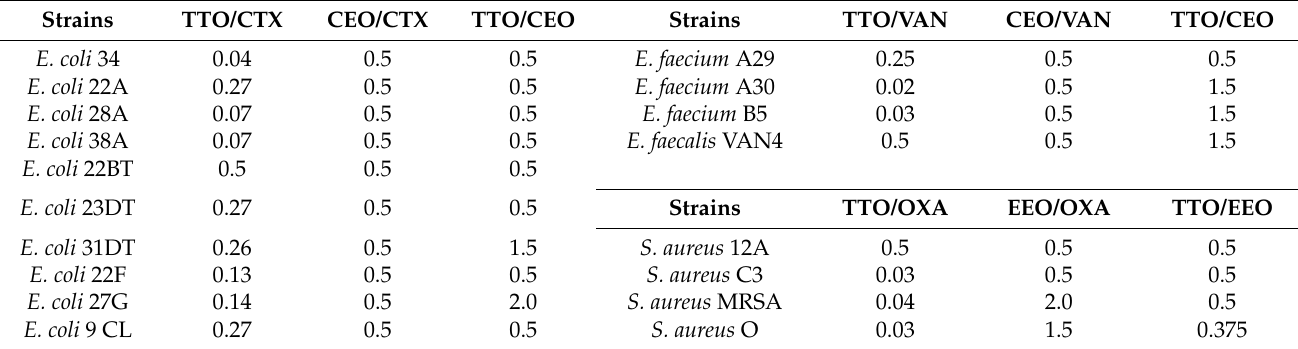
Table 5. Examples of synergistic activity of EO–EO associations and EO–antibiotic combinations against